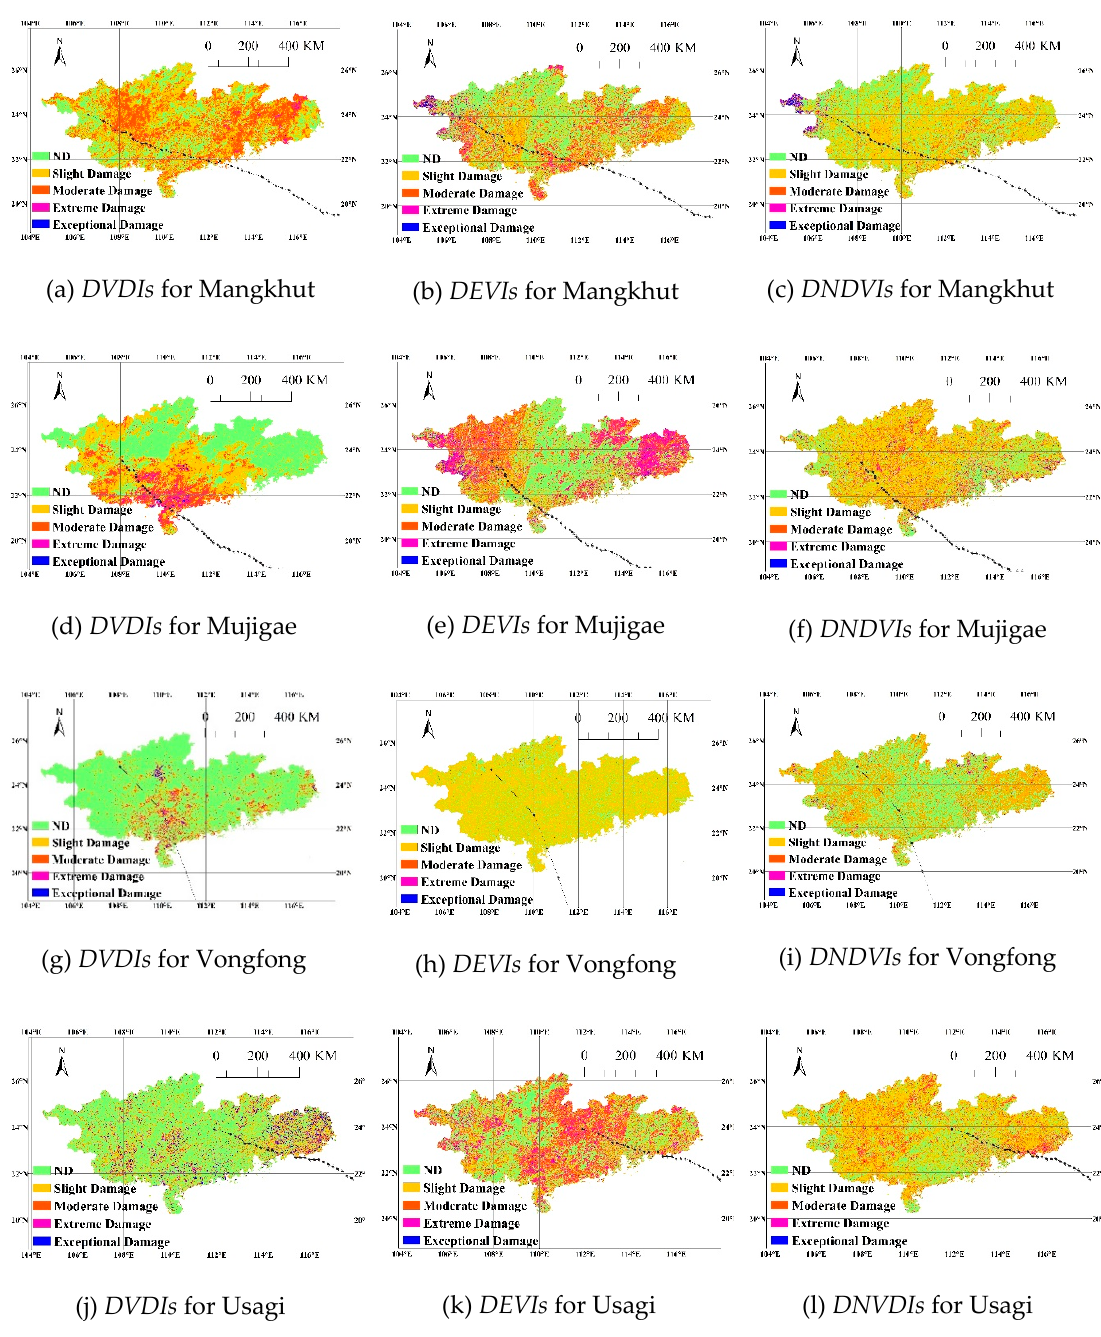
Figure 4. The comparison of DVDI , di ff erence in enhanced vegetation index ( DEVI ) and normalized di ff erence vegetation index ( DNDVI ) results fortyphoon Mangkhut (201822), Mujigae (201522), Vongfong (200214) and Usagi (201319): ( a , d , g , j ) are DVDIs for the 4 presentative typhoons respectively; ( b , e , h , k ) are DVDIs for the 4 presentative typhoons respectively; ( c , f , i , l ) DVDIs for the 4 presentative typhoons